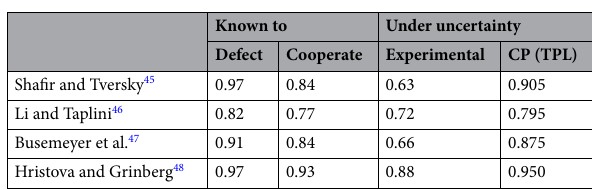
Table 1. The probability of choosing defection by a second player according to average results of different versions of PD task reported in 12 .